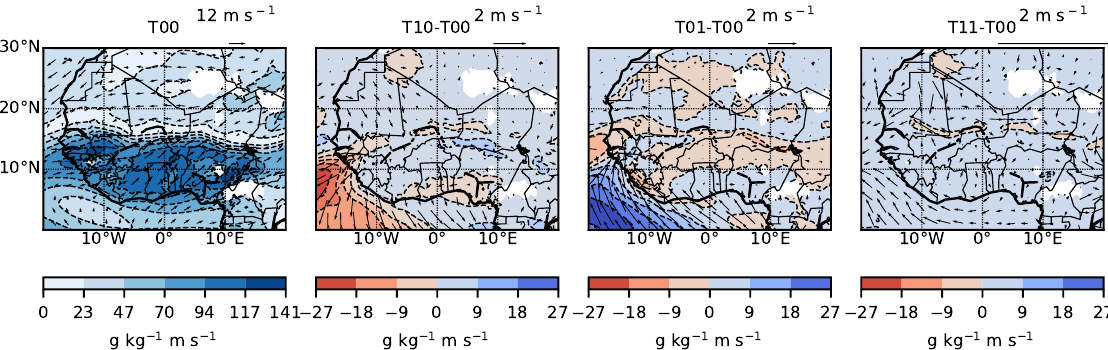
Figure 11. Mean JAS 925 hPa wind speed (arrows) and moisture transport (shading) for the control simulation and sensitivity experiment anomalies. Note the different wind speed